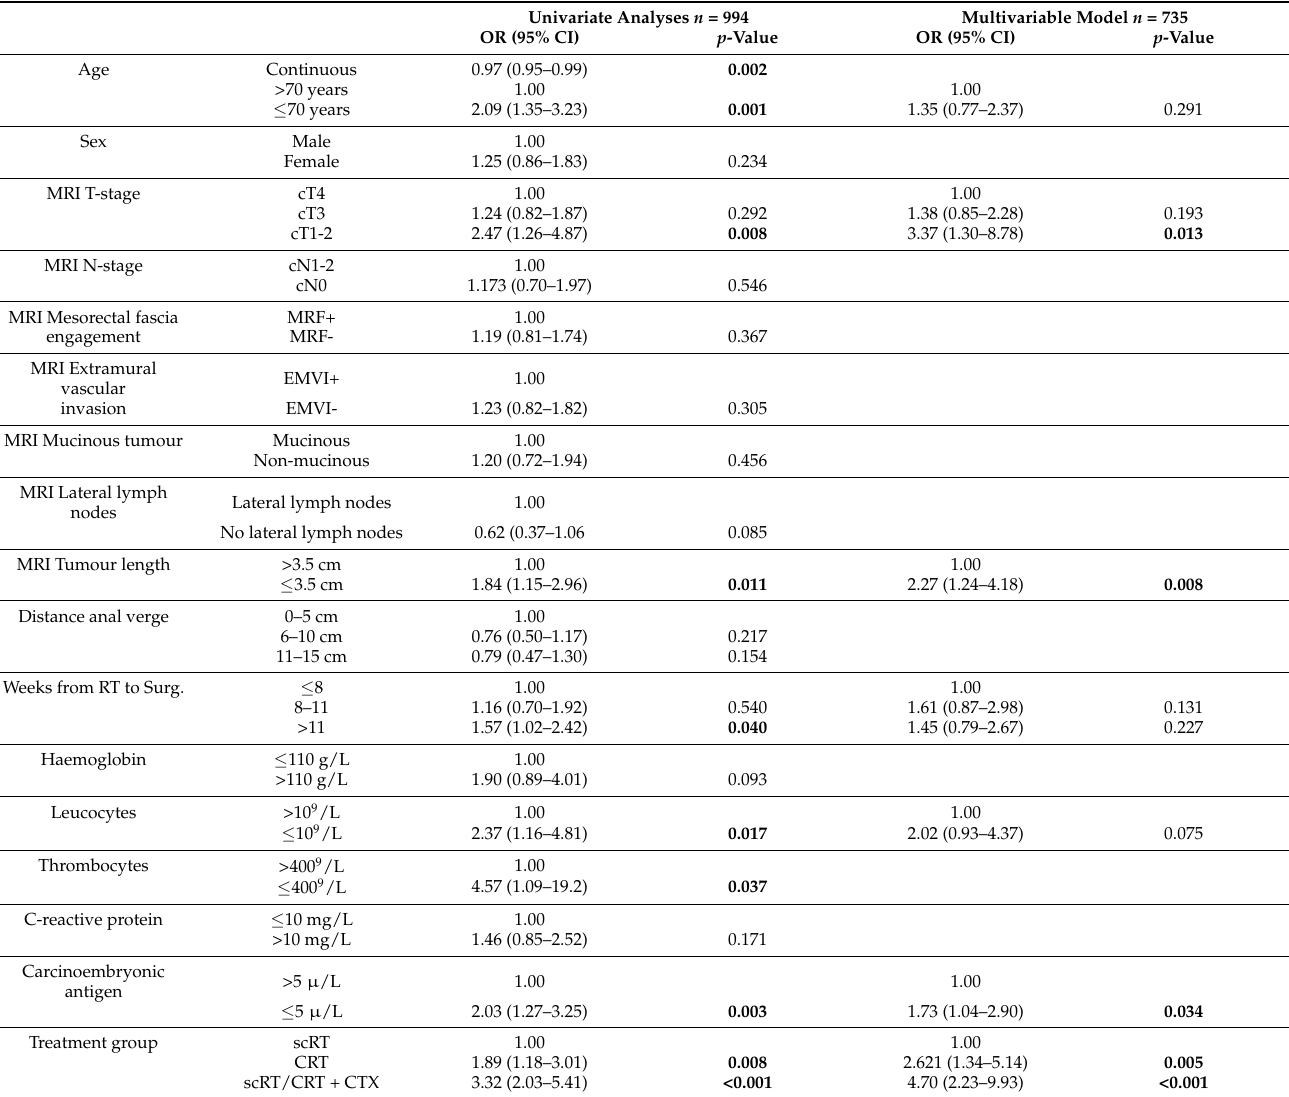
Table 4. Univariate and multivariate logistic regression analyses of the pooled cohort ( n = 994 and 735, respectively) for clinical, laboratory, and imaging-defined factors predicting pCR status. Univariate Analyses n =